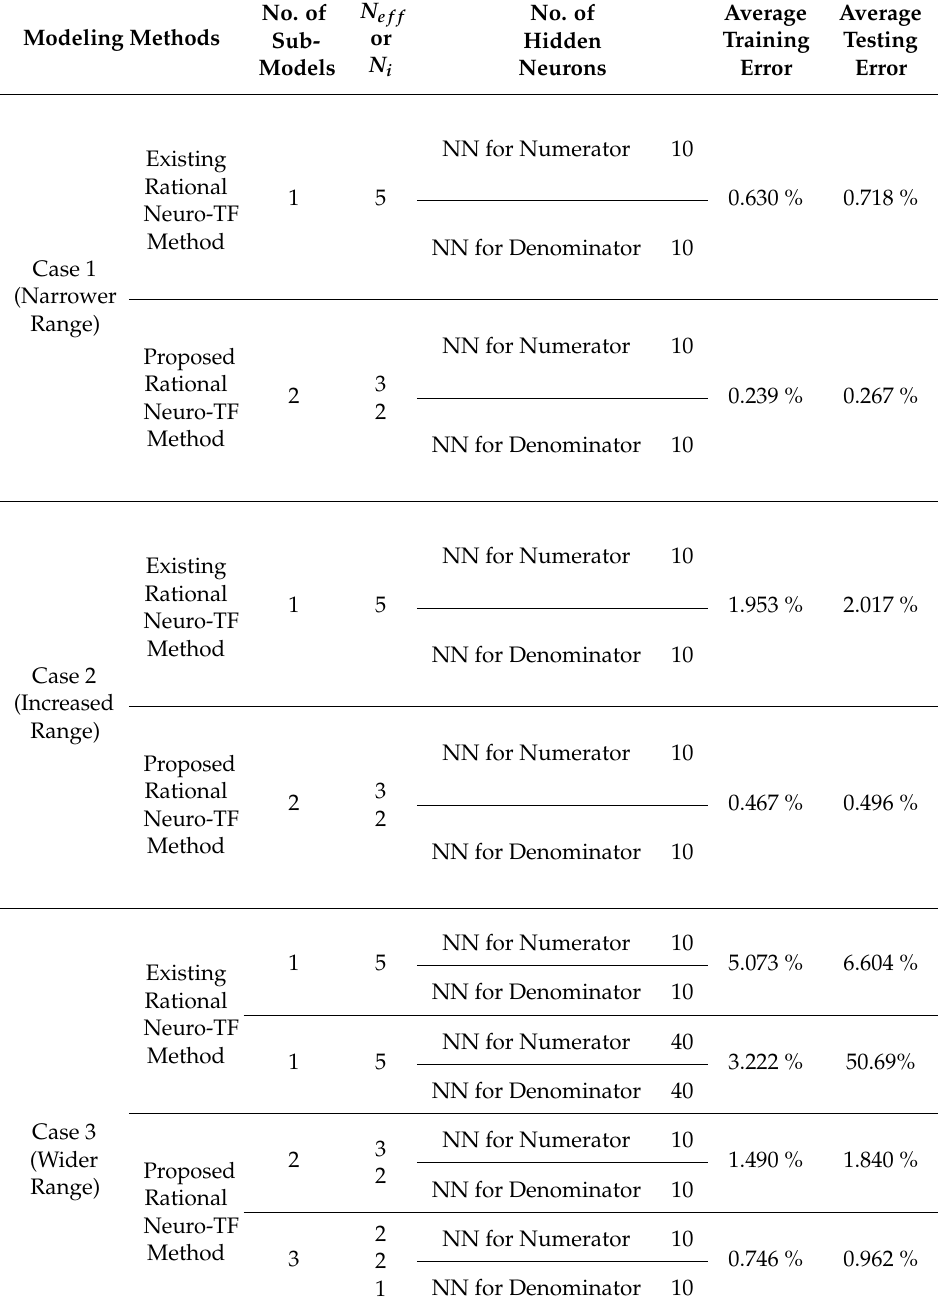
Table 3. Comparisons of different rational-based neuro-TF modeling approaches for the three-order waveguide filter